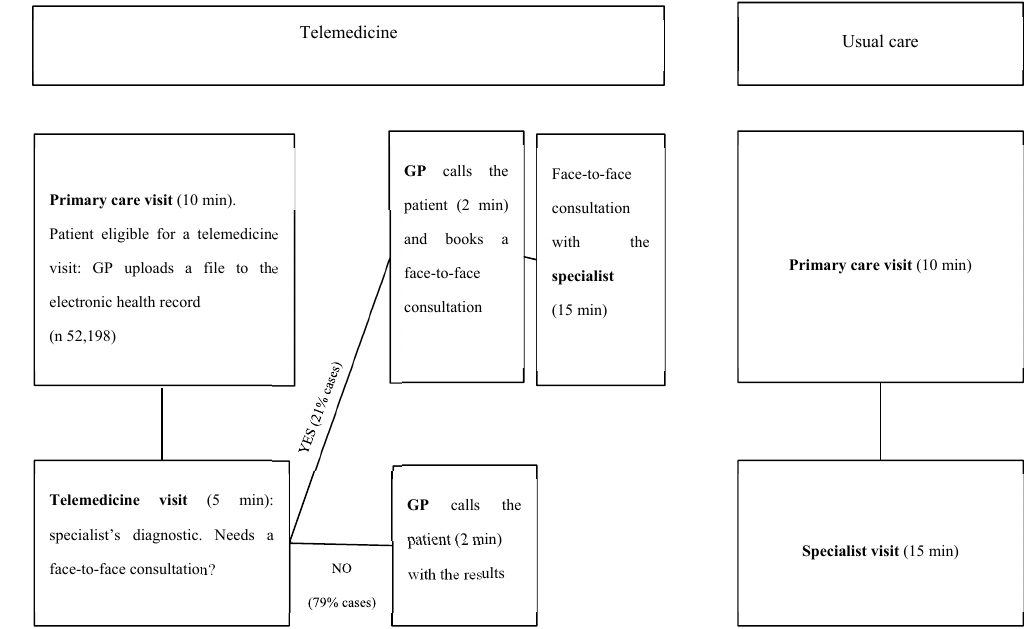
Figure 1. Patient flow: telemedicine vs. usual care.